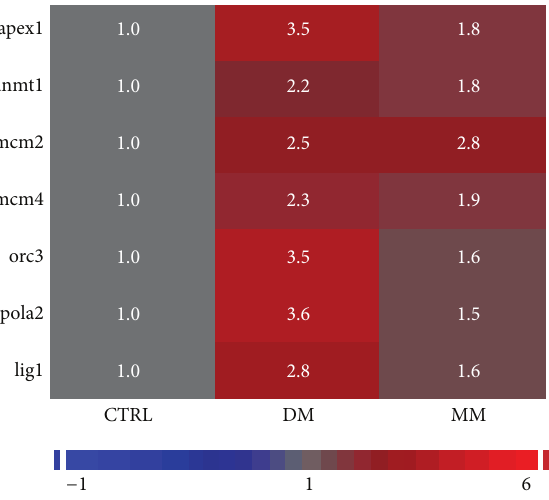
Figure 3: Heat map of expression of genes that are with altered expression in both the DM and MM condition and that are critical members of the DNA replication/DNA metabolic process group. As indicated, all genes listed were found to be upregulated.